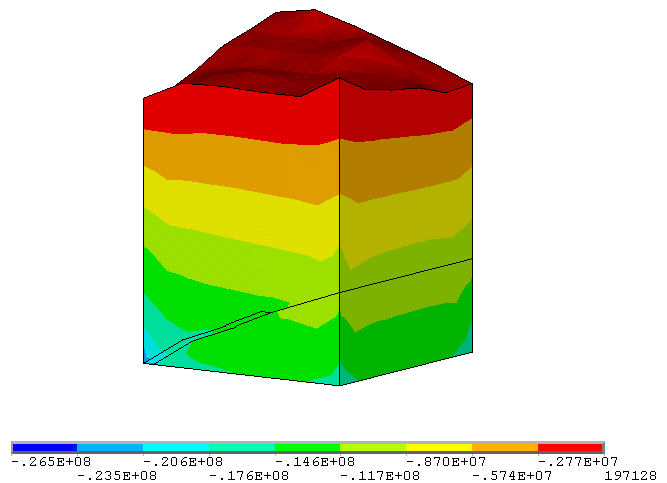
Figure 7. Dead-weight stress field calculation results.